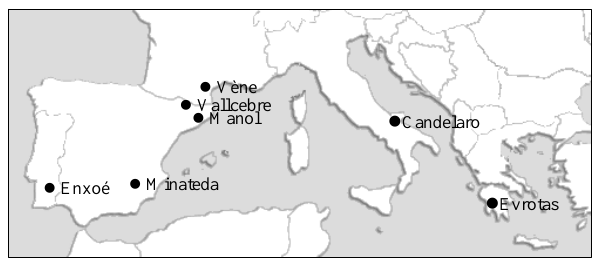
Fig. 1. Location of the main streams